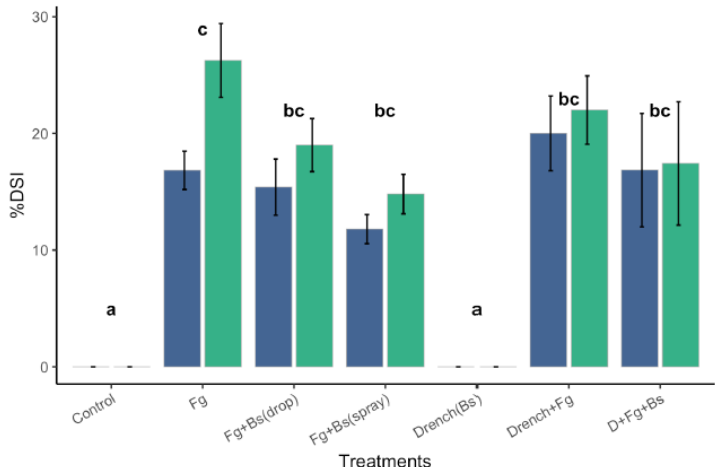
Figure 10. Disease severity index (DSI) of IHA with Bd-21 treated with Fg -K1-4 and EU07 at 7dpi and 14 dpi. Severity of infection of Fg -K1-4 on Bd-21 plants was determined for the Bd-21 plants treated and non-treated with Bacillus EU07 ( Bs ) and infected with or without Fg- K1-4. Spray Treatments using Bs to control Fg- K1-4 showed significant differences with the Fg -K1-4 treatments (drenched or not). Treatments applying drops or spraying Bs showed similar level of control over the Fg- K1-4. Data were from one independent experiment of at least seven repeats and shown as the mean ± SE. Experiments were replicated four times and similar results were obtained. Bars clusters with different letters were significantly different according to Tukey’s Test (α < 0.05) following two-way mixed ANOVA. n = 330. ( Fg -K1-4 = F. graminearum , D = Drench, Bs = Bacillus strain EU07). There was no significant interaction between the treatments and time on the % DSI score, F (6, 59) = 1.642, p = 0.152, partial η 2 = 0.143. The main effect of time exhibited a